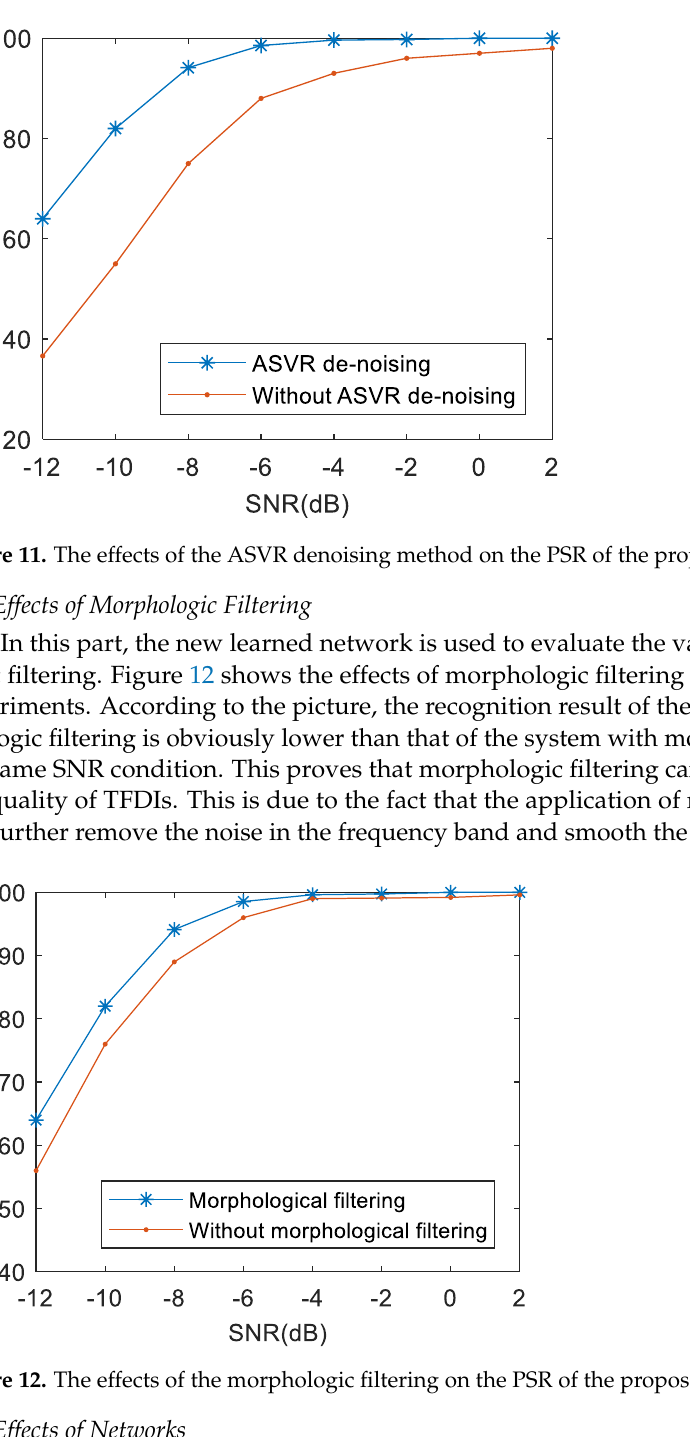
4 Figure 10. Confusion matrix for the system at the SNR of −8 dB.